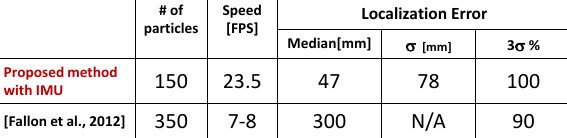
Table 1. Comparison of the performances